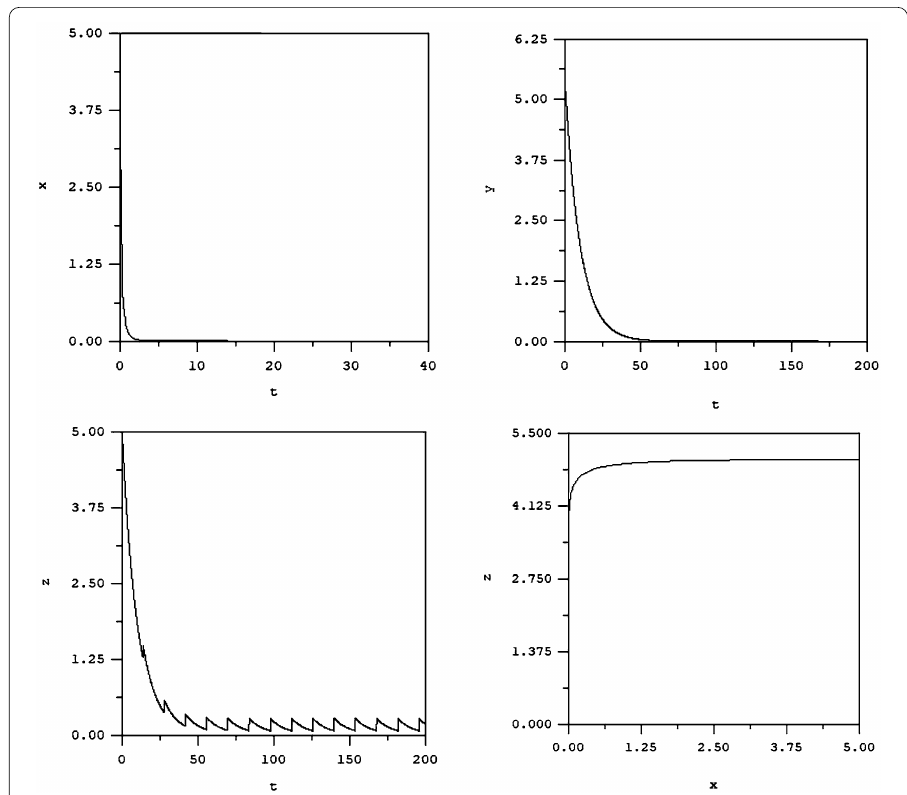
Figure 1 A computer simulation of the impulsive differential equations (1a)–(1f). The solution trajectory tends toward the oscillatory solution (0,0, ˜ z ( t )) as time progresses. Here, a 1 = 0.21, a 2 = 0.1, a 3 = 0.247, b 1 = 0.2, b 2 = 0.1, b 3 = 0.1, k 1 = 0.1, k 2 = 0.017, α = 0.1, γ = 0.9, δ = 0.2, T = 14, x (0) = 5, y (0) = 5, and z (0) = 5 in which all conditions in Theorem 1 are